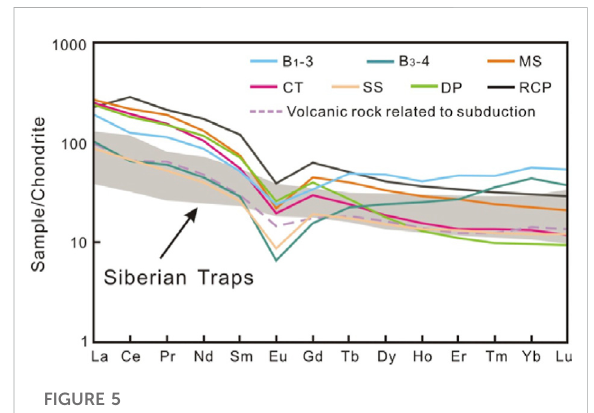
FIGURE 5 Chondrite-normalized REE patterns of the tonsteins in the C 1 coal, PTB volcanic ashes and subduction-related rock.